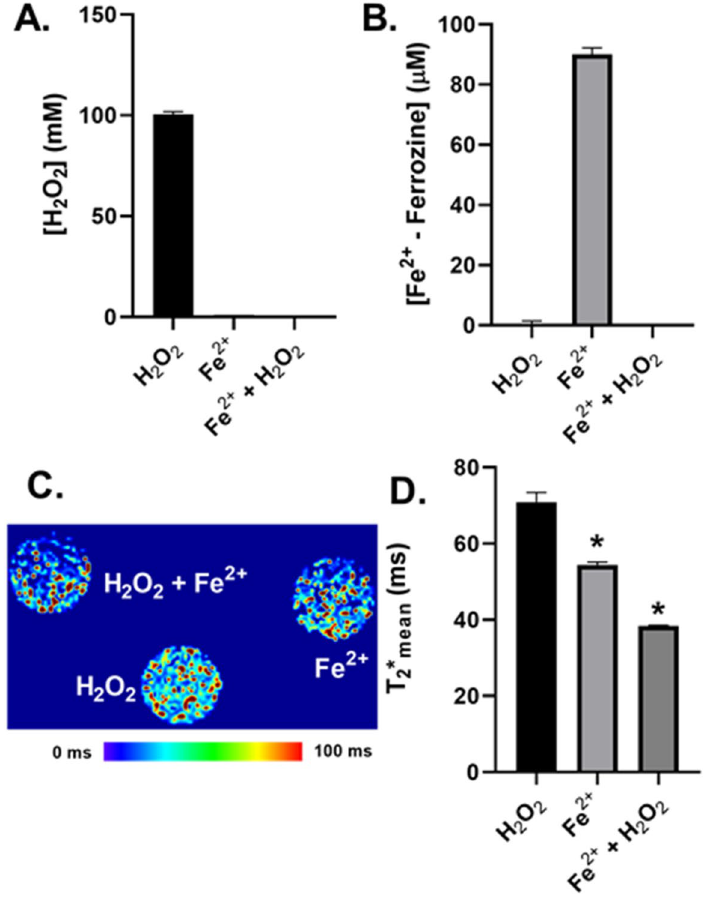
Figure 2. T 2 * mapping detects Fenton chemistry. ( A ) Measurement of H 2 O 2 using UV–Vis spectroscopy (240 nm; ε = 46.3 mol −1 cm −1 ; 1 cm pathlength) following 15 min incubation of 1.5 mM FAS ((NH 4 ) 2 Fe(SO 4 ) 2 6H 2 O) with 100 mM H 2 O 2 for 15 min in double-distilled H 2 O. ( B ) Measurement of Fe 2+ following 1:15 dilution in 5 mM ferrozine using UV–Vis spectroscopy (562 nm; ε = 27,900 mol −1 cm −1 ; 1 cm pathlength). ( C ) Representative T 2 * map of 1:15 dilution in 1% agarose gel. ( D ) Mean T 2 * relaxation times quantified using Slicer3D software by generation a 1 mm ROI for each phantom and calculating the mean T 2 * relaxation time using the data quantification package within the software. Error bars represent SD of n = 3 biological replicates. Statistical analysis was performed using a one-way ANOVA test with statistical significance defined as a false positivity rate less than 5% (* p <